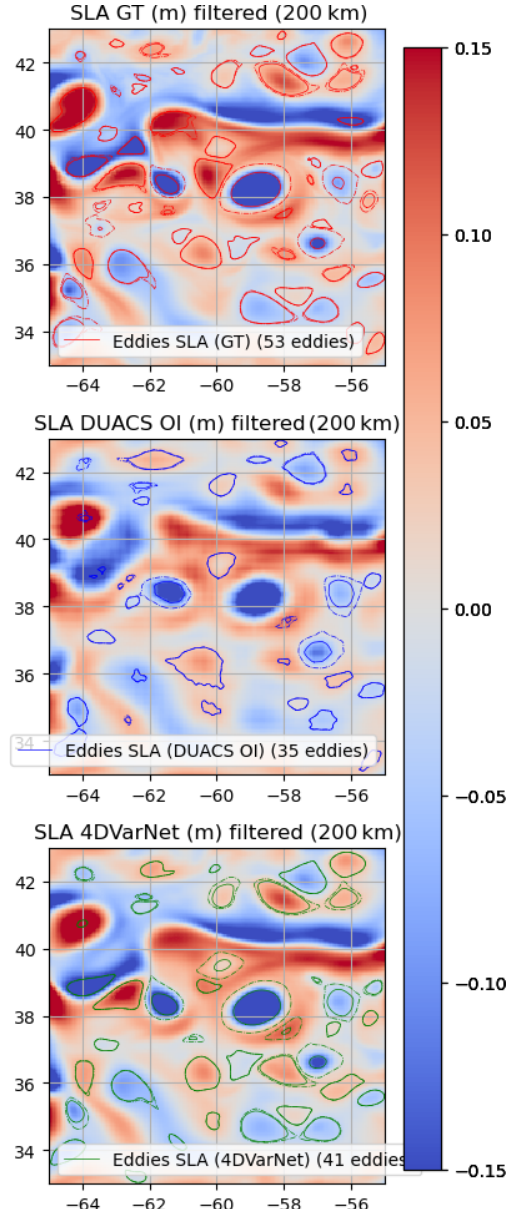
Figure 10. Eddies detected on the GULFSTREAM domain (25 Oc- tober 2012) over SSH (one SWOT plus four